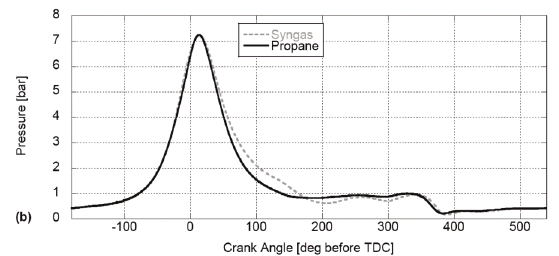
Fig. 4. The pressure course in the combustion chamber as a function of the crankshaft rotation angle for "One Load"